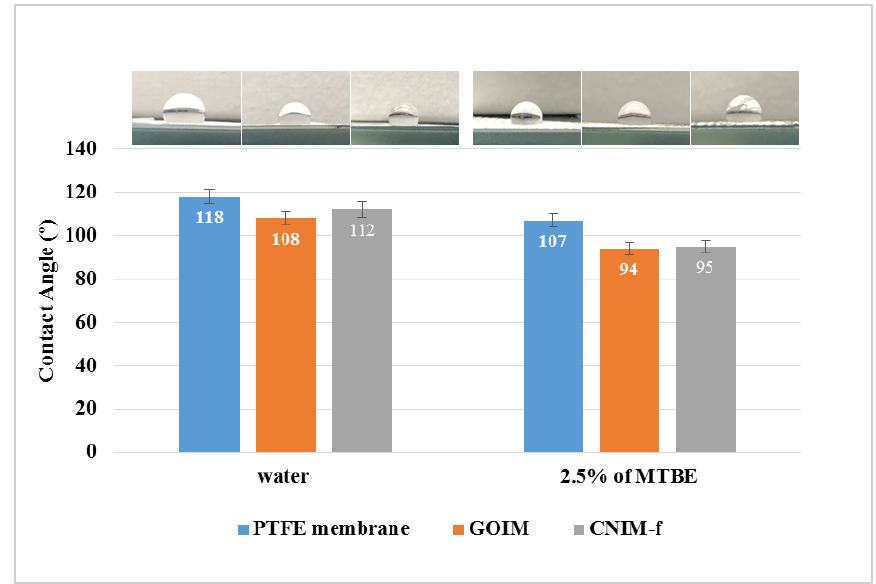
Figure 5. Photographs and contact angle of water and aqueous MTBE (2.5 wt%) drops on PTFE membrane, GOIM and CNIM-f. membrane, GOIM and